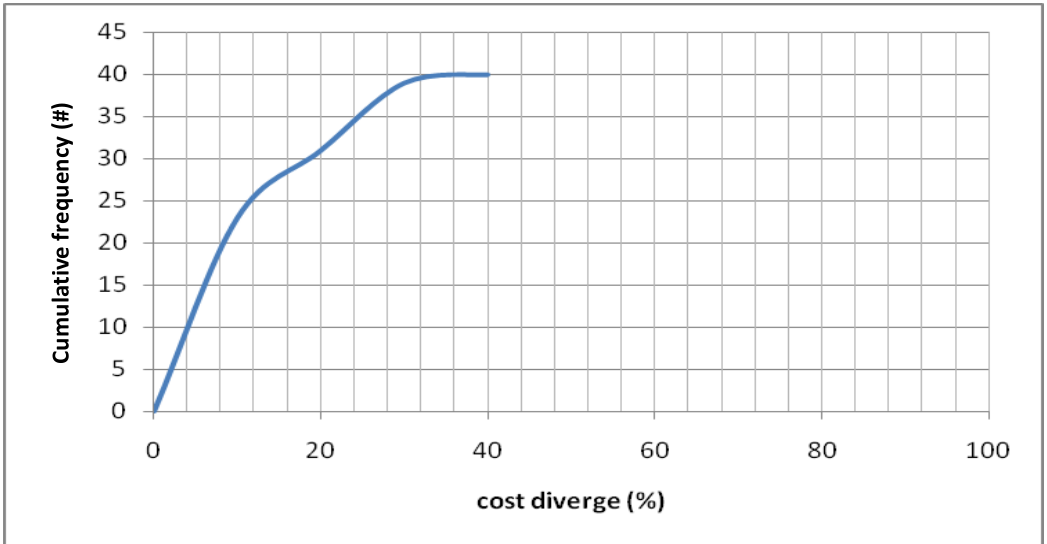
Figure 2 S-curve of cost overestimation in road construction projects in the West Bank